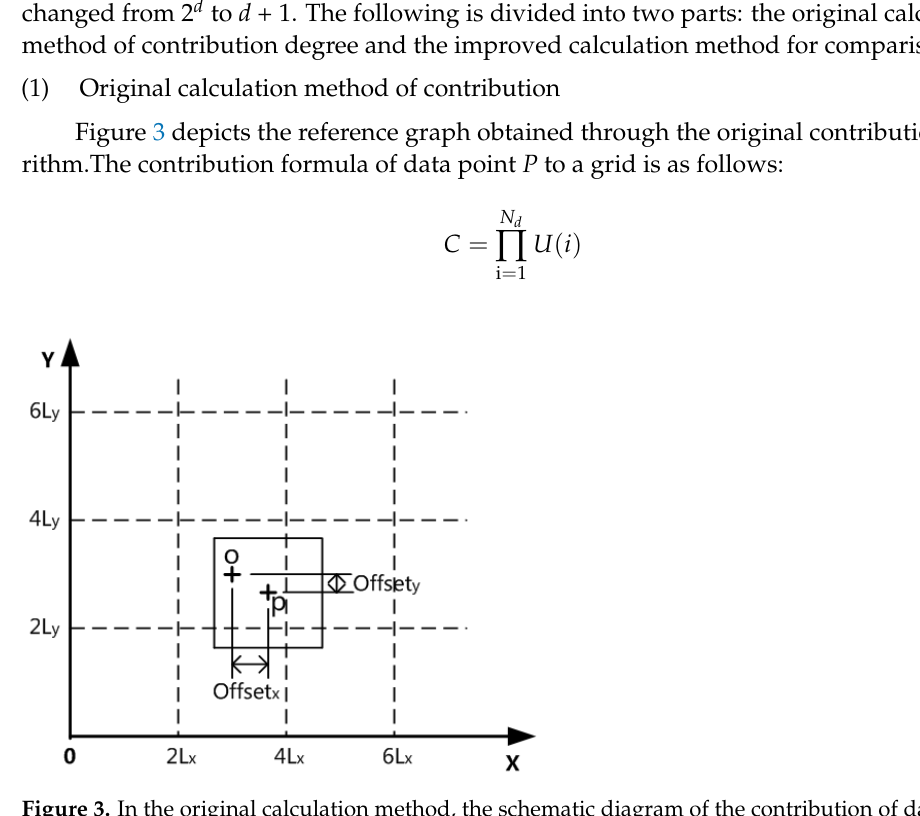
Figure 3. In the original calculation method, the schematic diagram of the contribution of data point P in two-dimensional space. P in two-dimensional